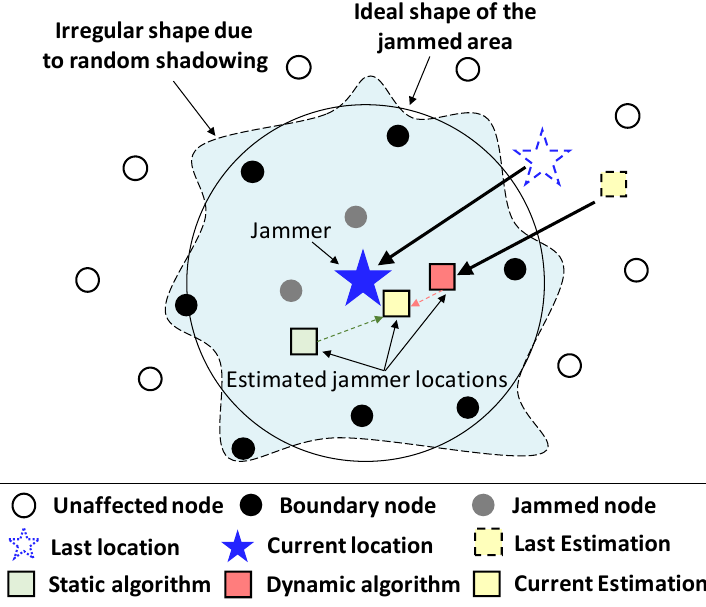
Figure 4. Illustration of near-field capturing